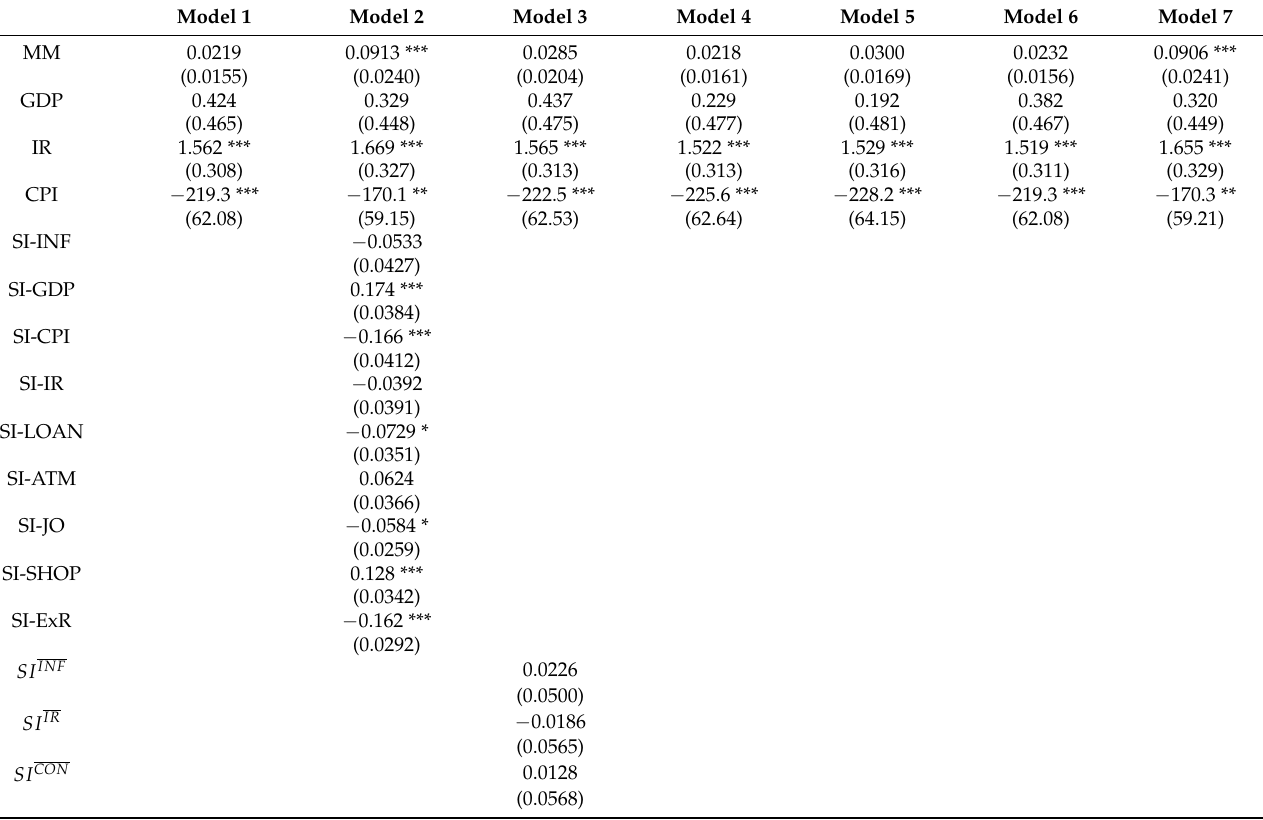
Table A13. Panel Regression Table Fixed-Effects OM Models